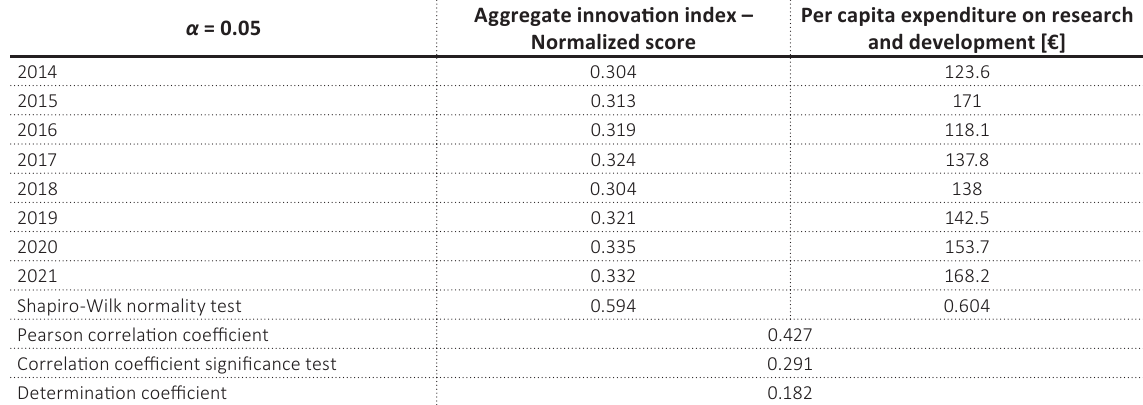
Table 1. Test statistics –